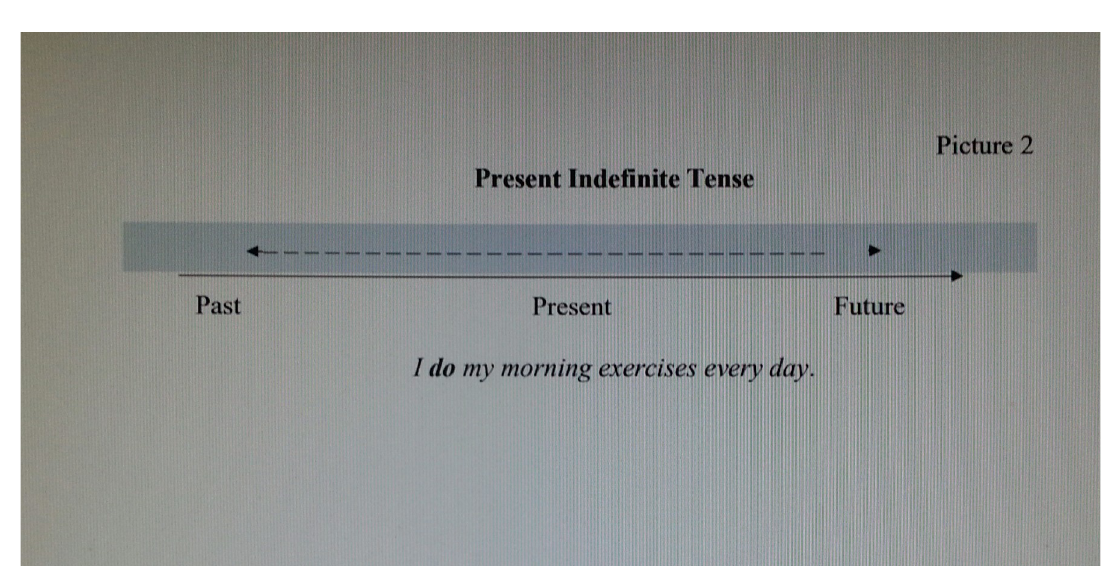
Figure 2 - Present Indefinite Tense: "OBSERVATIONAL WINDOW" is closed (time